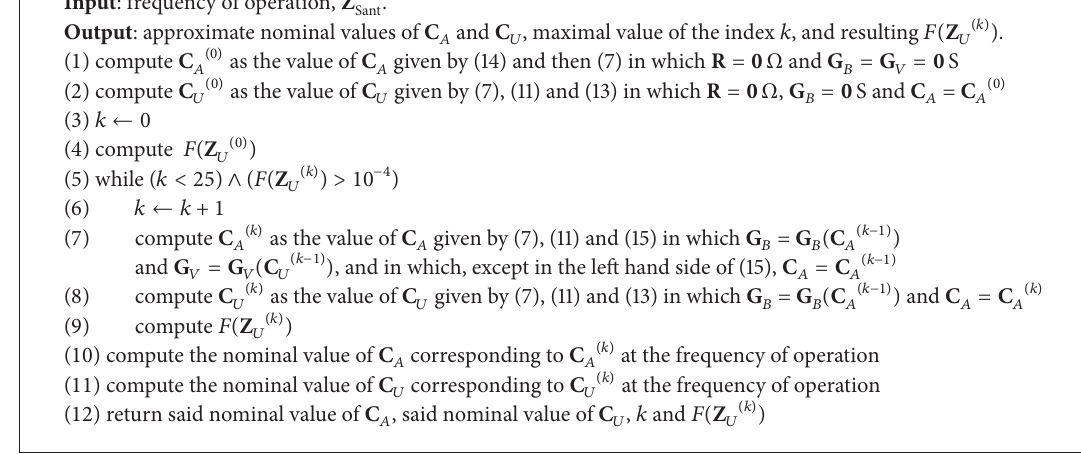
Algorithm 1: Iterative algorithm for computing approximate nominal values of C 𝐴 and C 𝑈 .